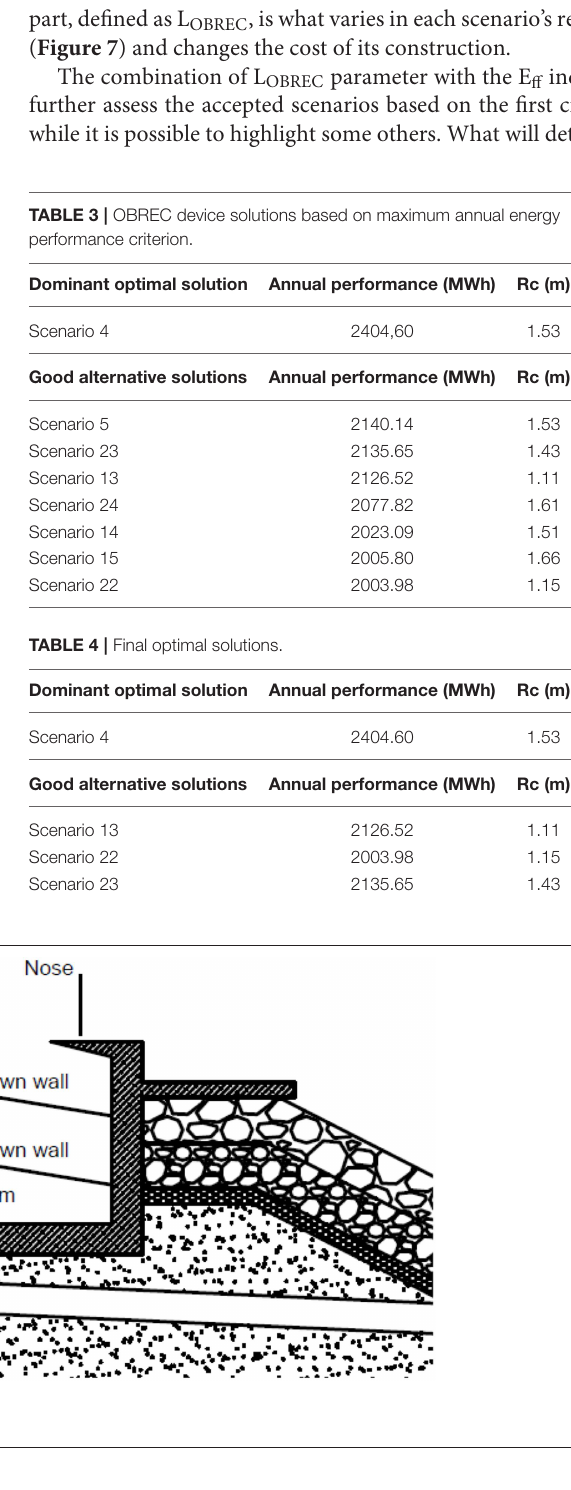
Frontiers in Energy Research |